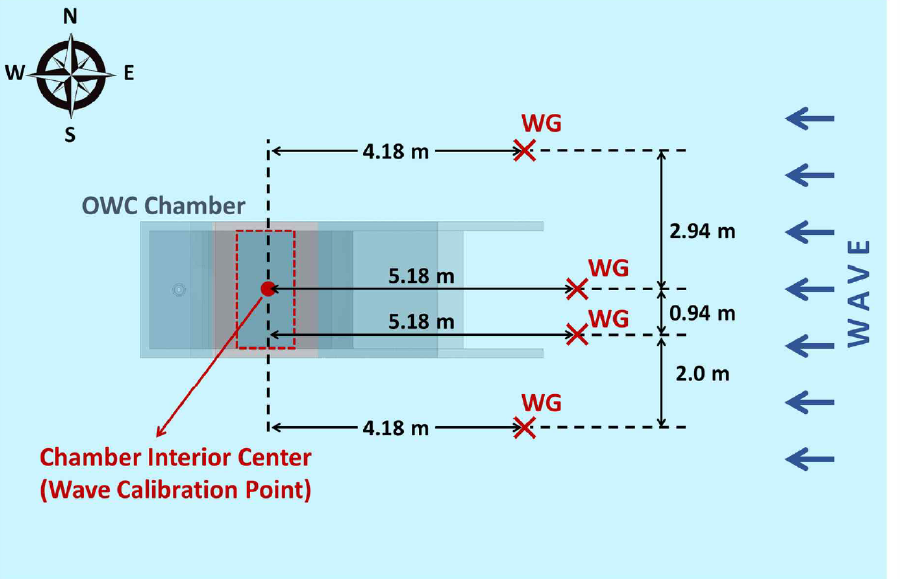
Figure 2. The location of the wave probes in the basin.